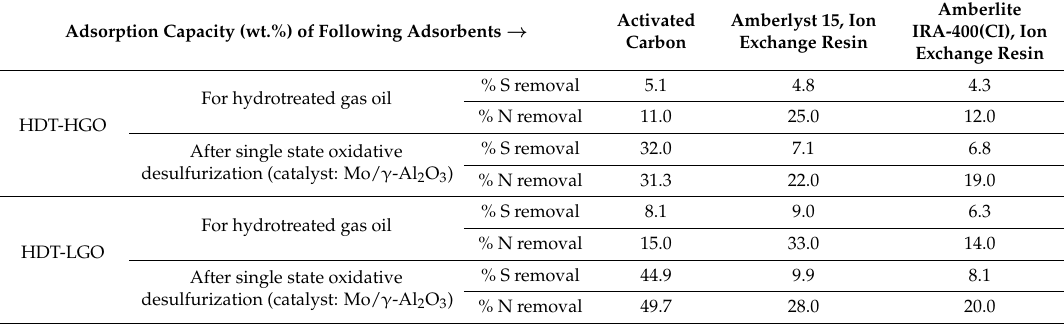
Figure 7. Simplistic mechanism for the oxidation of sulphur containing compounds via TPHP in presence of catalyst. Table 2. Adsorption capacity of various adsorbents for sulphur and nitrogen compounds present in gas oil. (error ± 1%).